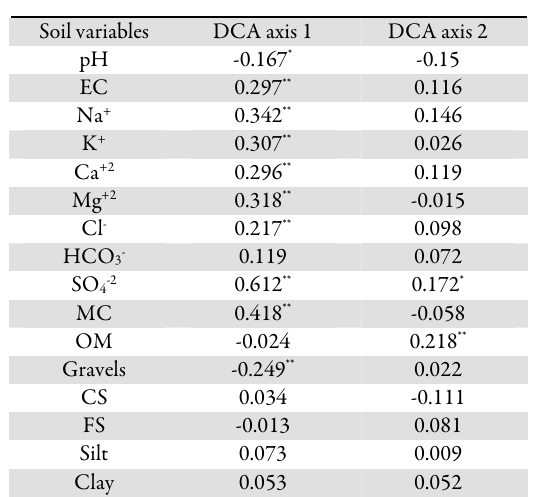
Tab. 4. Simple linear correlation coefficient (r) between the soil variables and DCA axes. *= p<0.05, **: p<0.01. For soil factors abbreviations and units, see Tab. 4.